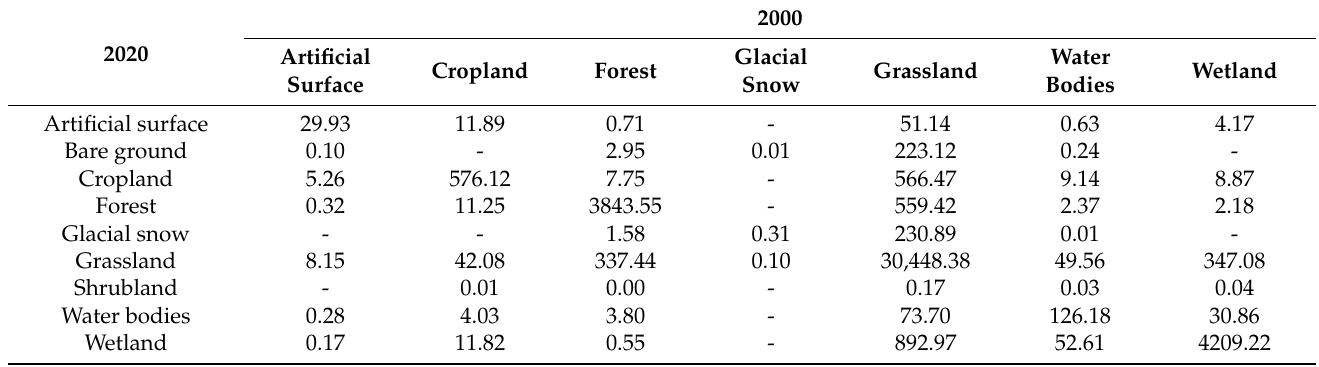
Table 4. Land cover area transfer matrix of Zoig ê alpine grassland from 2000 to 2020 (unit: km 2